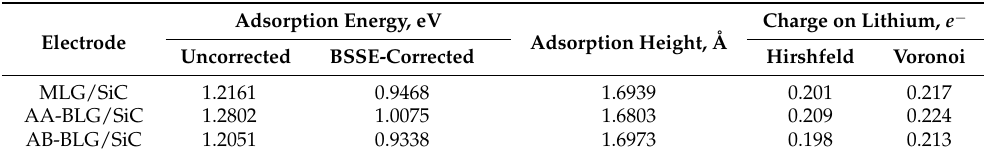
Table 2. DFT-derived parameters describing lithium adsorption on all considered electrodes. The positive charges on Li atom means that the charge is transferred from Li to electrode